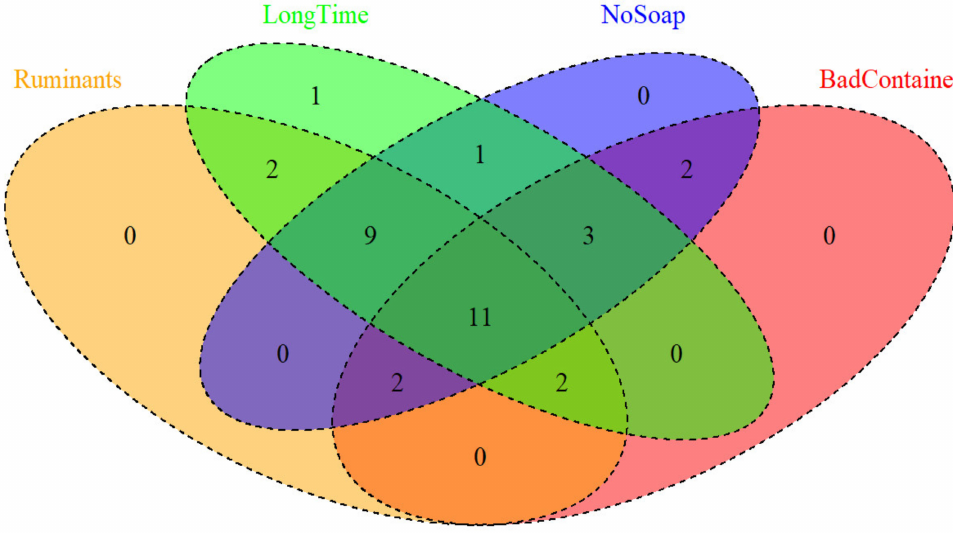
Figure A1. Venn diagram showing the number of households who have various combinations of the causal conditions